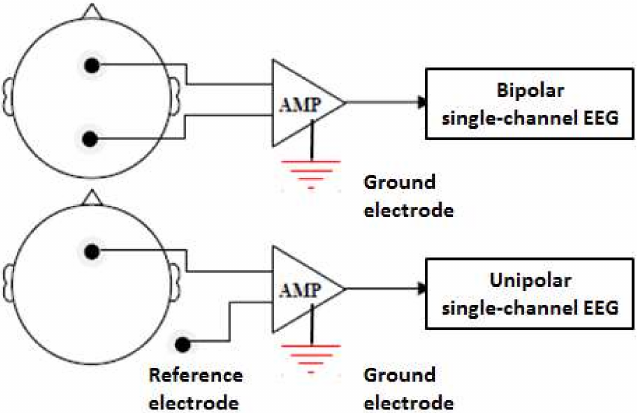
Figure 4. The type of EEG channels. Bipolar type ( top ) and unipolar type or monopolar ( bottom